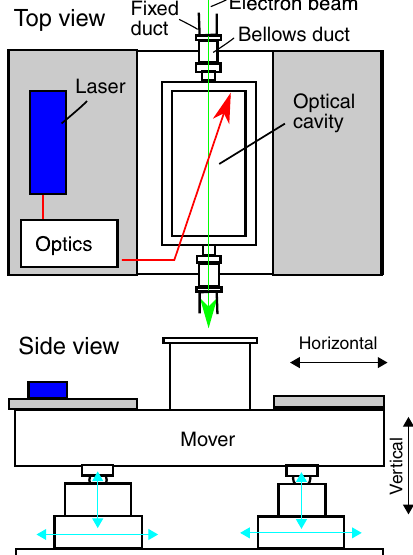
FIG. 11. Schematic drawing of the cavity system. The whole